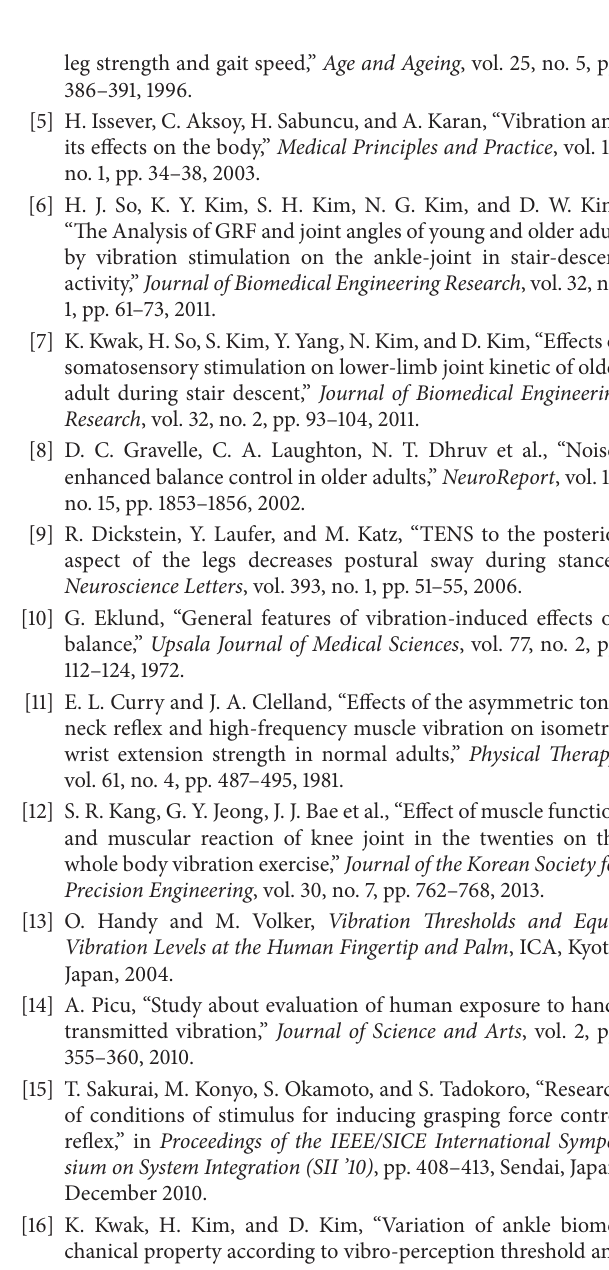
Table 6: The muscle reaction time according to the intensity of vibration, perception threshold (100%) and subthreshold (80%) on the tibialis anterior tendon [Sec]. Lower leg muscles Soleus 0.181 ± 0.036 100% 0.171 ± 0.033 180Hz 0.859 Tibialis 100% 0.188 ± 0.037 anterior 190 Hz 0.549 tendon 100% 0.191 ± 250 Hz